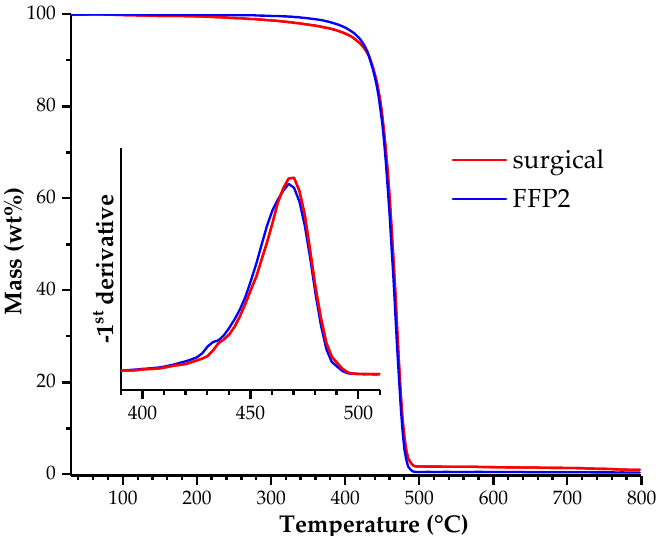
Figure 2. TGA curve of surgical and FFP2 facemasks in the range from 30 to 800 °C. The onset was focused on the 400–500 °C range.